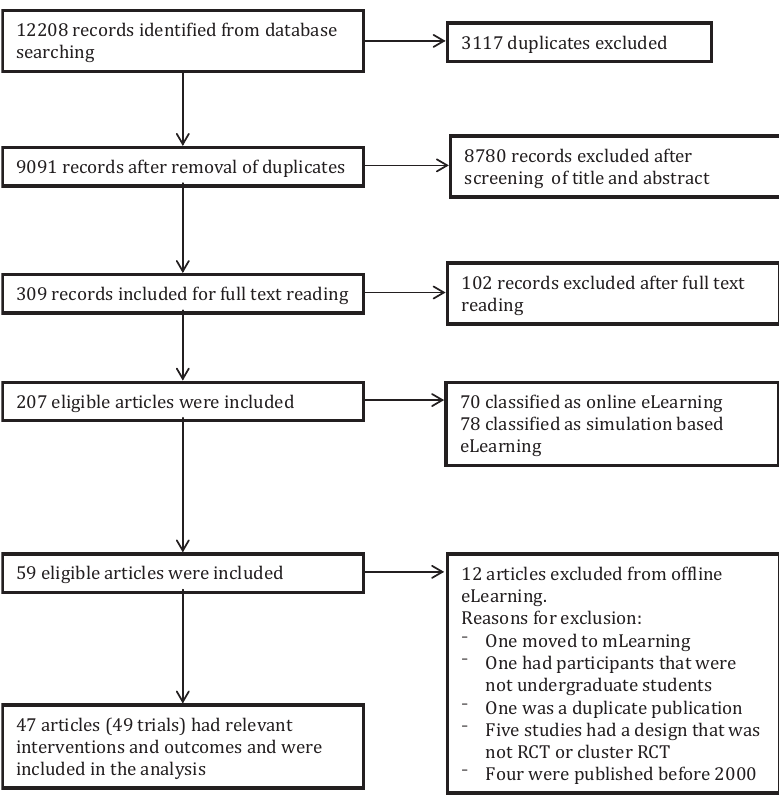
Figure 1. Flowchart of the studies included in the